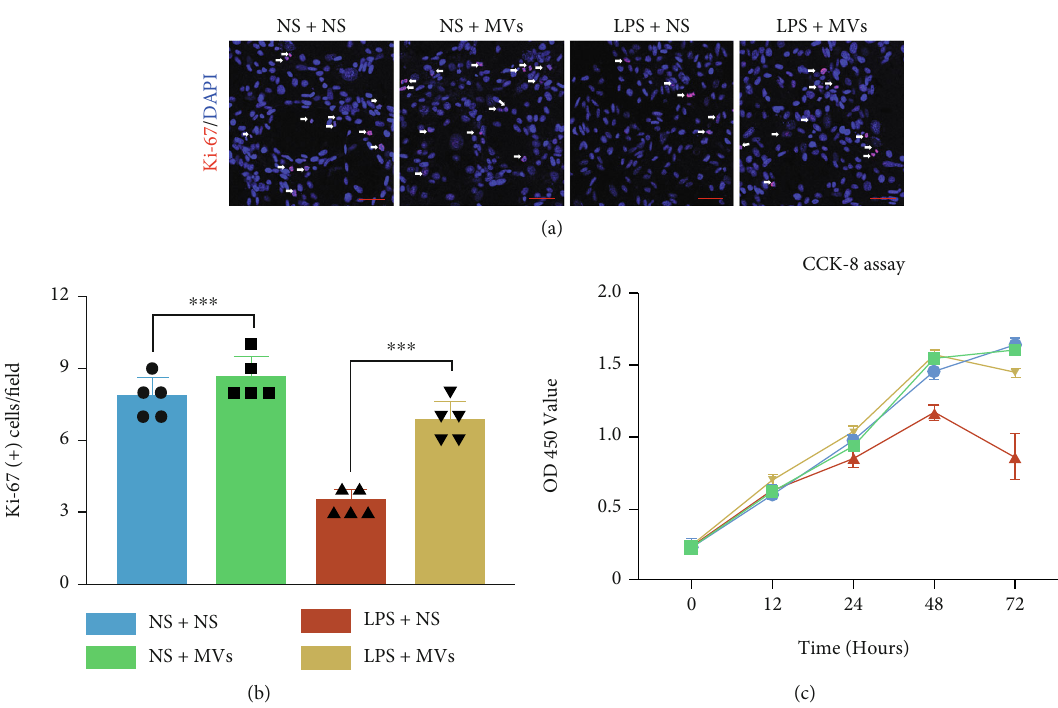
Figure 8: MVs improve MLE-12 cell proliferation following LPS-induced injury. (a) Representative immuno fl uorescence images stained by Ki-67 (red) in MLE-12 cells, scalebar = 100 μ m. (b) Quantitative analysis of Ki-67-positive cells in MLE-12 cells treated by LPS with or without MVs for 48 hours ( N = 5 , ANOVA, ∗∗∗ P < 0 : 001 ). (c) CCK-8 analysis of MLE-12 cells ’ viability ( N = 5 ,